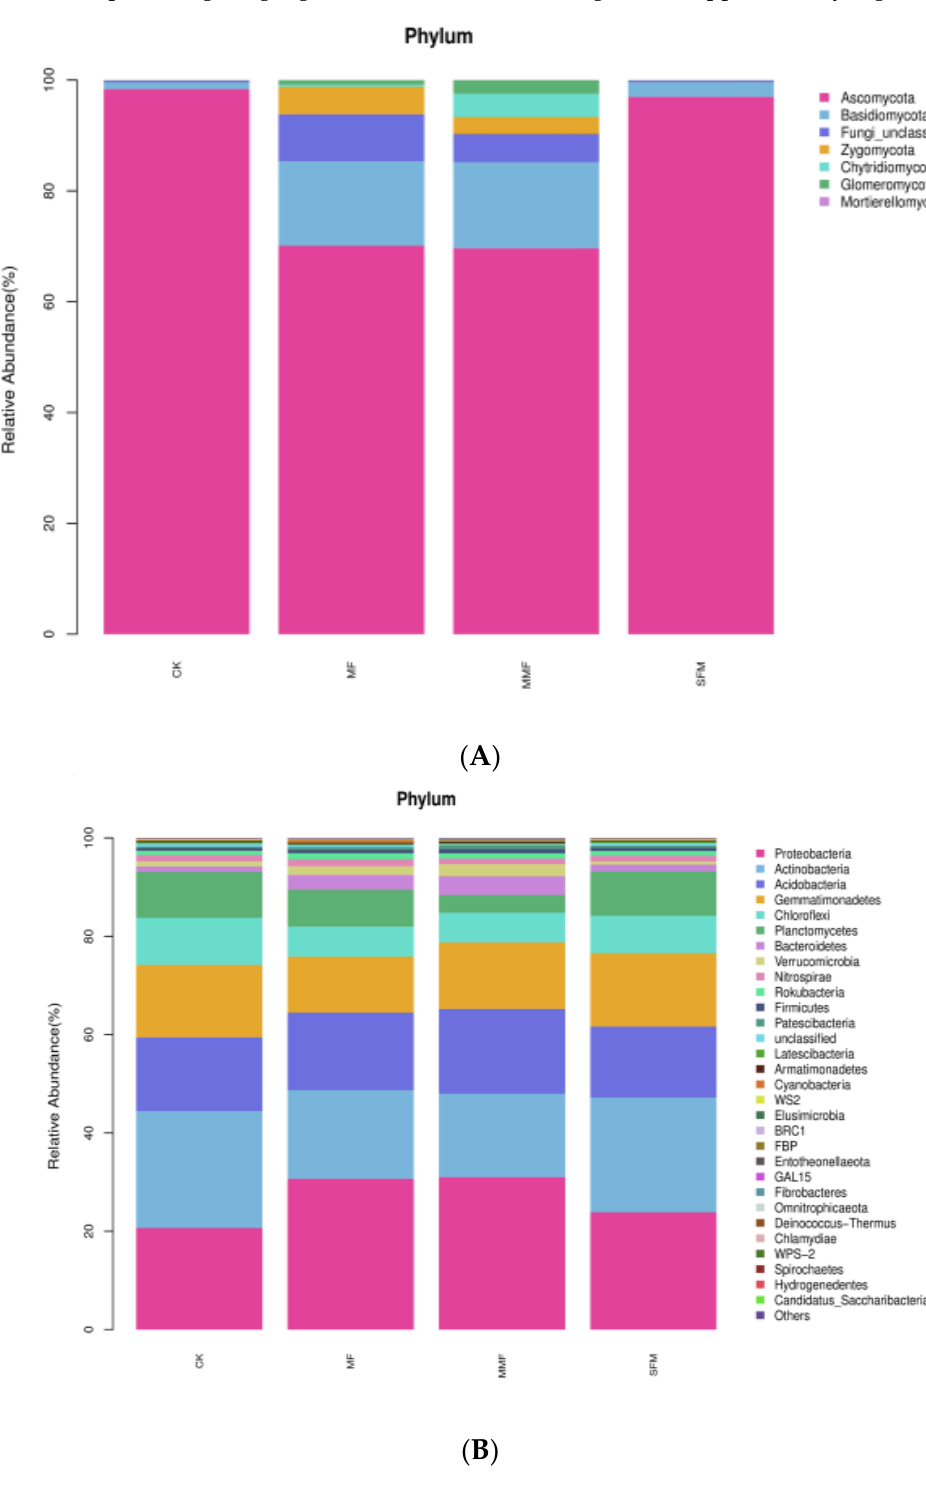
Figure 3. The taxonomic distribution of fungi and bacteria of Lanzhou lily rhizosphere soil among different treatments from Illumina NovaSeq: top 7 fungal phyla ( A ) and top 30 bacterial phyla ( B ).